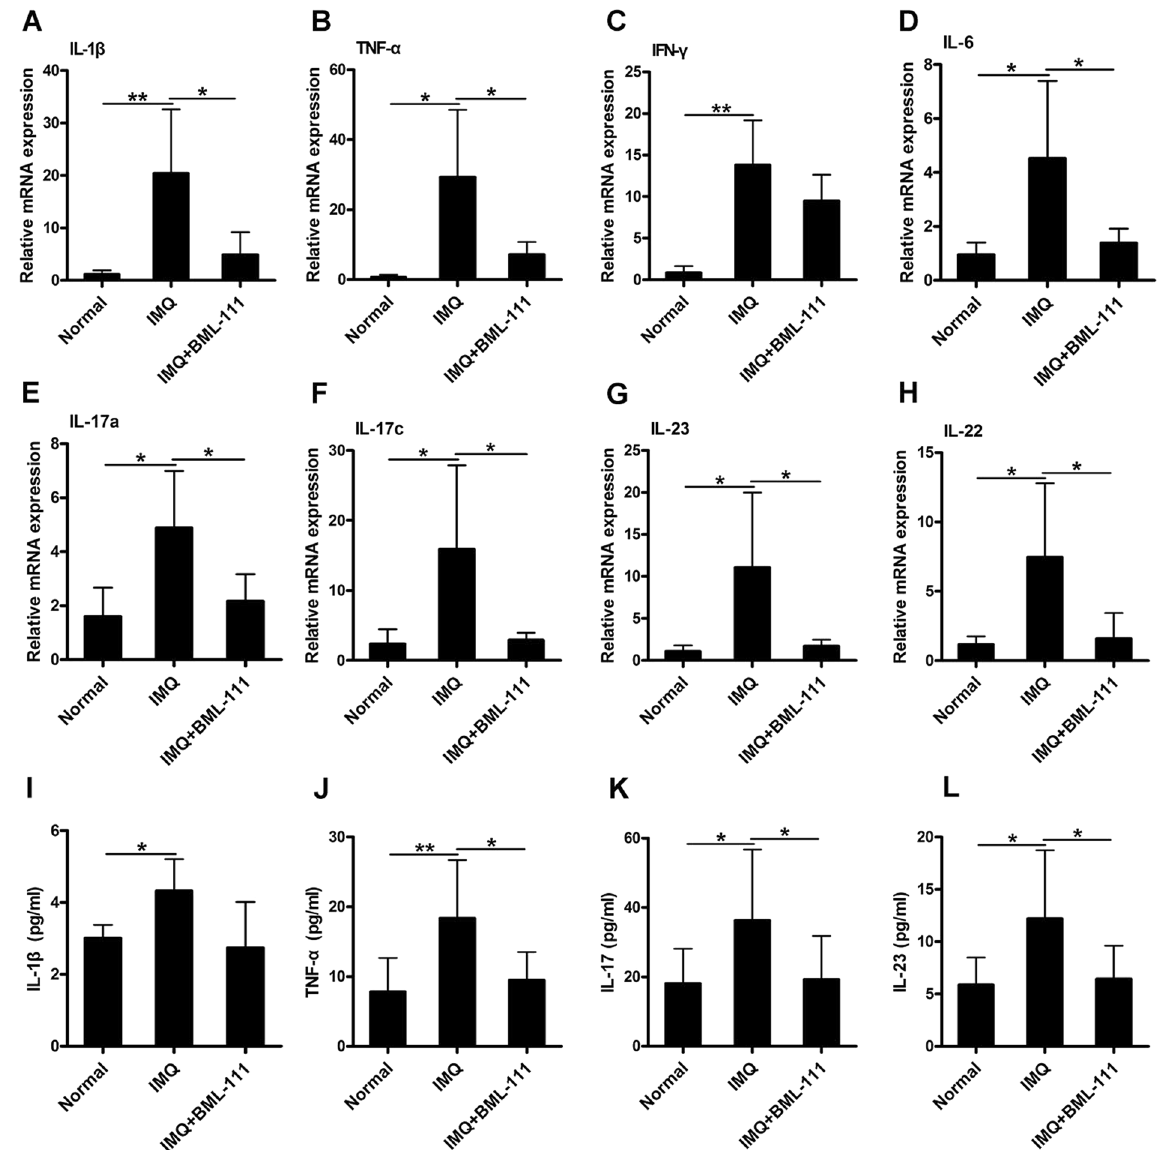
Figure 4. BML-111 decreases the inflammatory cytokines expression in IMQ-induced psoriasiform dermatitis in mice. Real-time quantitative PCR was performed to analyze the mRNA expression of IL-1 β ( A ), TNF- α ( B ), IFN- γ ( C ), IL-6 ( D ), IL-17a ( E ), IL-17c ( F ), IL-23 ( G ), and IL-22 ( H ) in the skin biopsies from mice. The serum concentration of IL-1 β ( I ), TNF- α ( J ), IL-17 ( K ) and IL-23 ( L ) in the collected serum on day 8 was determined by ELISA. The results are shown in mean ± SD. ** p < 0.01 and * p < 0 . 05 when compared to mice treated with IMQ. All experiments were conducted thrice, and the representative results are